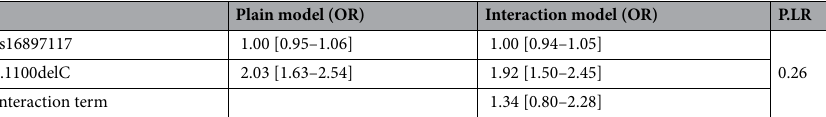
Table 3. The breast cancer risk associated with CHEK2 :c.1100delC and rs16897117 in the BCAC data. The models were adjusted for BCAC study and 10 principal